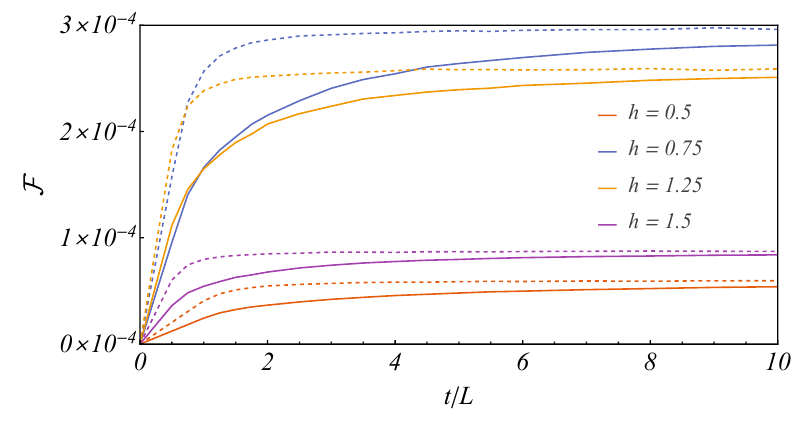
Figure 3: Quasi-particle growth for an interval, for different values of the transverse field h (different colors). Full lines are the multiplets predictions as expected from Eq. (40) whilst dashed lines are the results when pair-structure is considered. As expected, they are both approaching the same saturation value for large